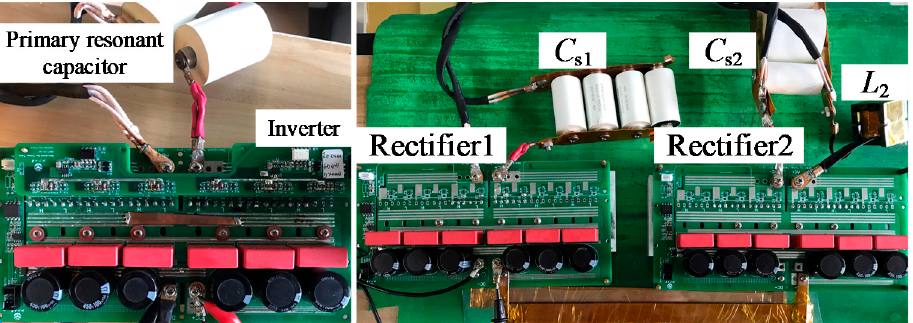
Figure 20. Experiment platform.